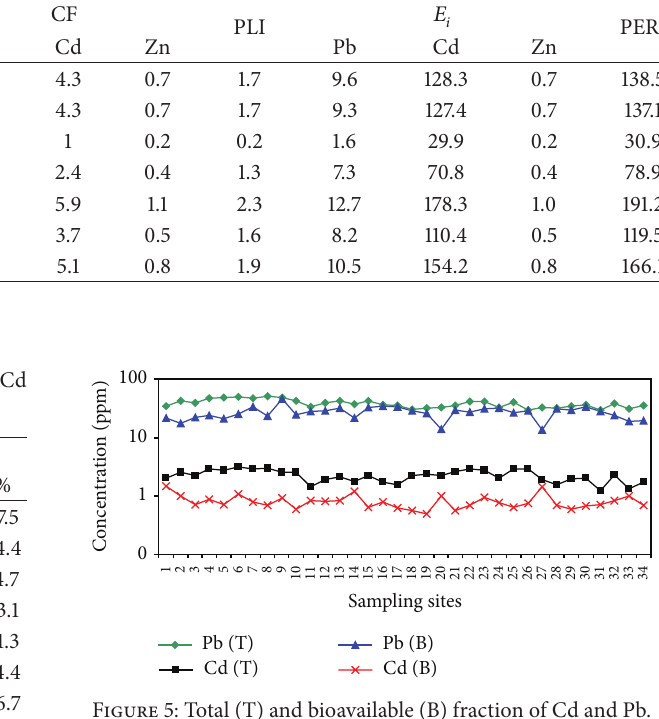
Figure 5: Total (T) and bioavailable (B) fraction of Cd and